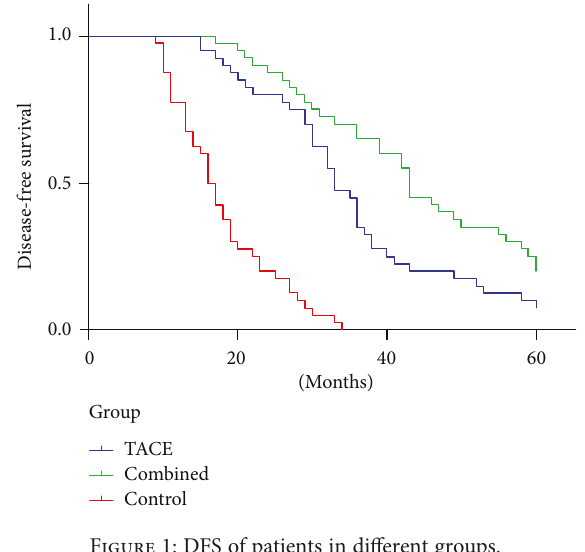
Figure 1: DFS of patients in di ff erent